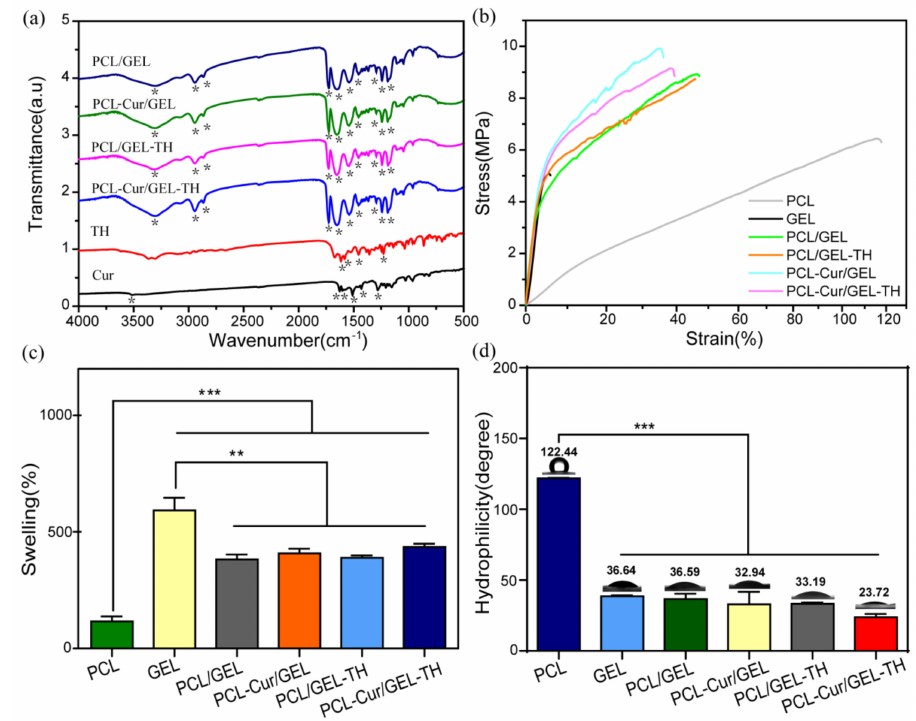
Figure 2. ( a ) FTIR spectra, the asterisks indicate the characteristic peaks of different samples. ( b ) Stress − strain curves. ( c ) Swelling abilities and ( d ) Water CAs ( n = 3) of different nanofibrous membranes; * p < 0.05; ** p < 0.01; *** p <